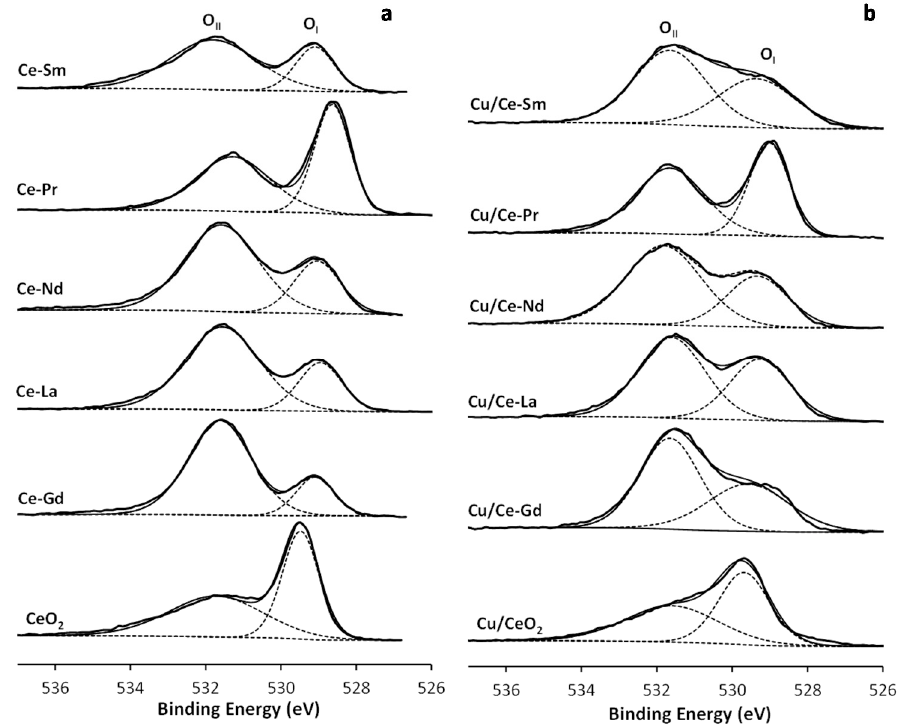
Figure 7. XPS O 1s spectra of the Ce-Ln ( a ) and Cu/Ce-Ln ( b ) samples, Ln: Gd, La, Pr, Nd, Sm.